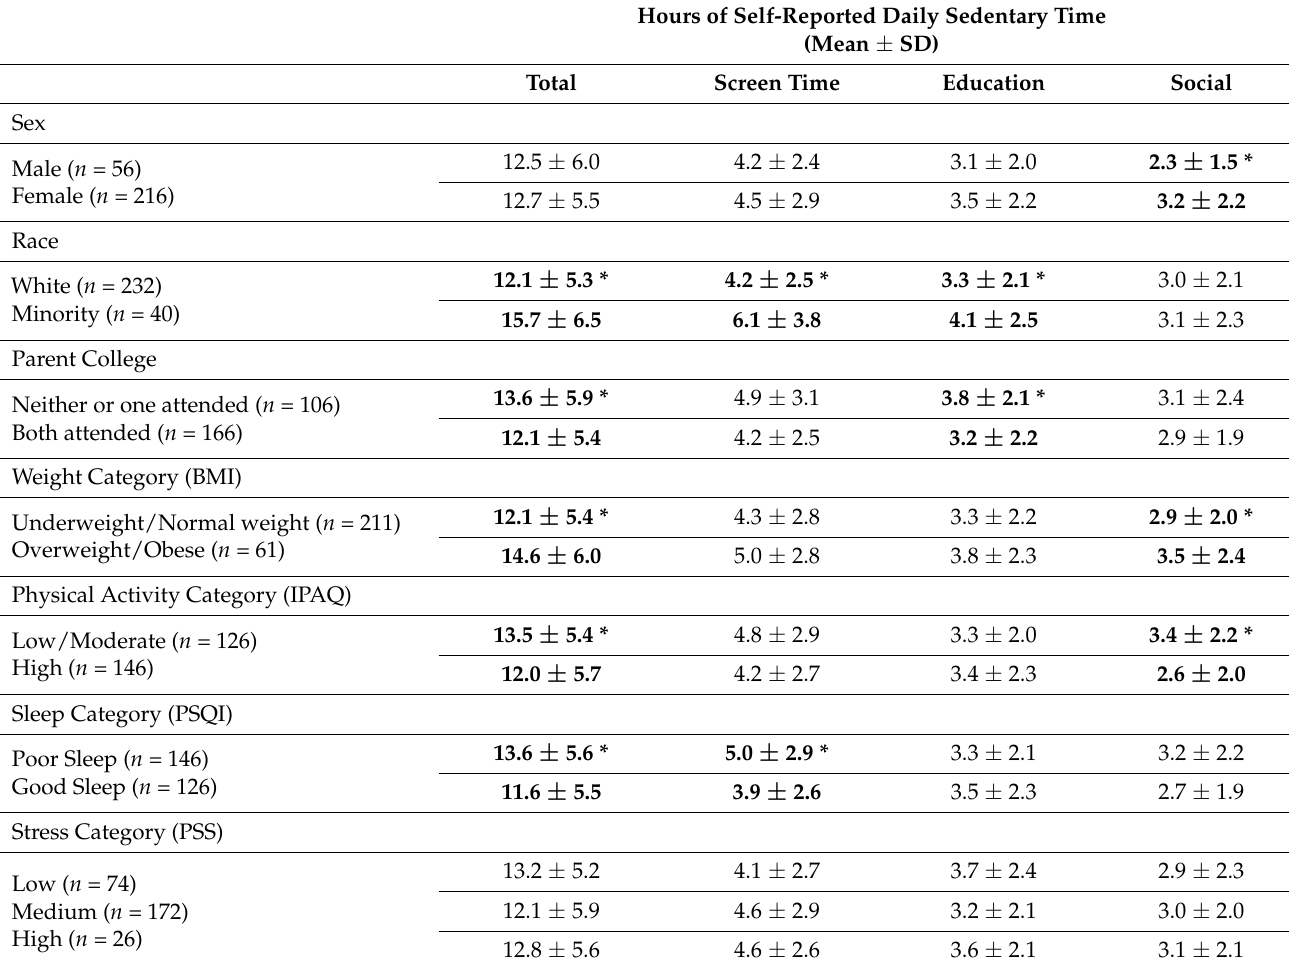
Table 2. Domain-specific sedentary behavior by sociodemographic and lifestyle factors. Hours of Self-Reported Daily Sedentary